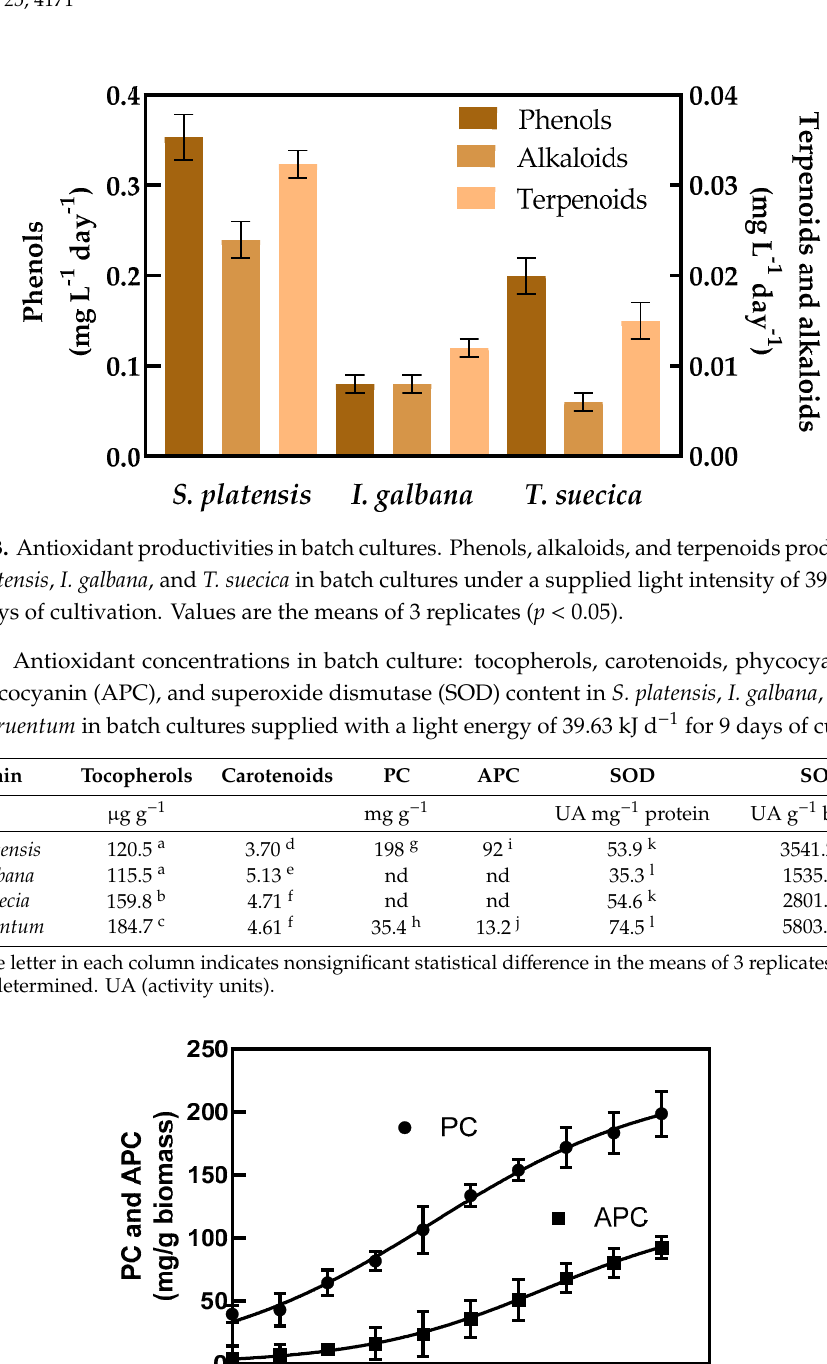
The same letter in each column indicates nonsignificant statistical difference in the means of 3 replicates ( p < 0.05). nd: not determined. UA (activity units).